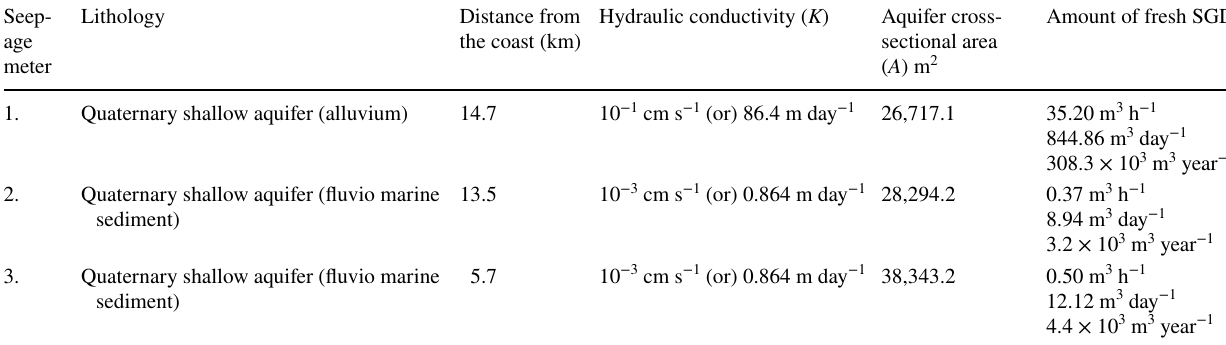
Hydraulic conductivity ( K ) the coast (km)